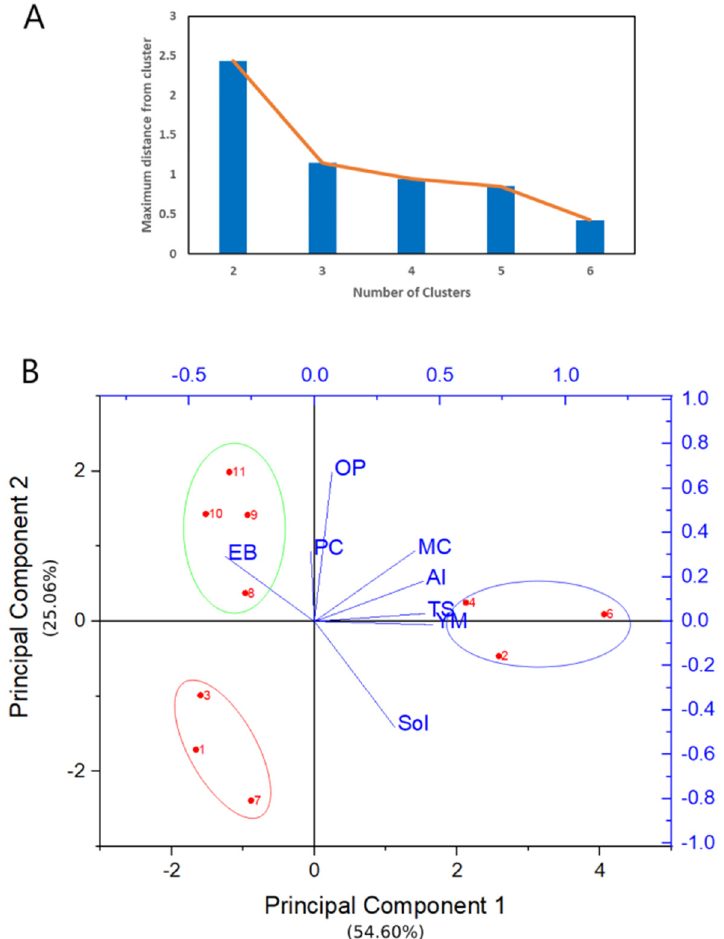
Figure 4. Relationship between the maximum distance to a cluster and the number of clusters during the k-means cluster analysis ( A ) and the PCA biplot between the first two principal components ( B ) where dots represent the scores plot and lines represent the loadings plot ( Al, alginate; PC, phenolic compounds; Sol, solubility; MC, moisture content; YM, Young Modulus; OP, opacity; TS, tensile strength; EB, elongation at break).